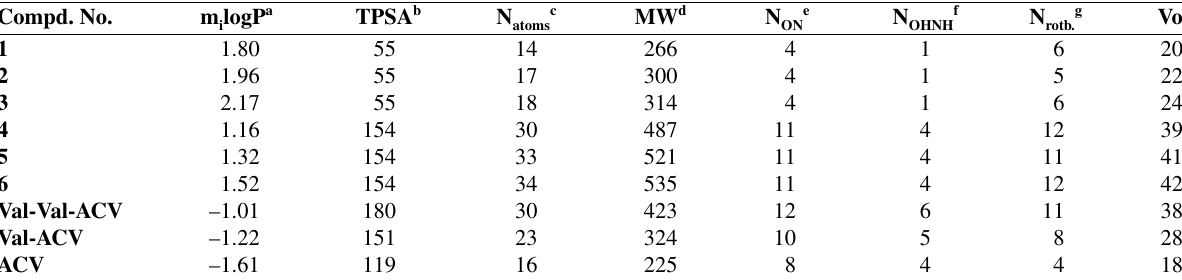
Table 2. Calculated physico-chemical properties of compounds 1 – 6 . Compd.